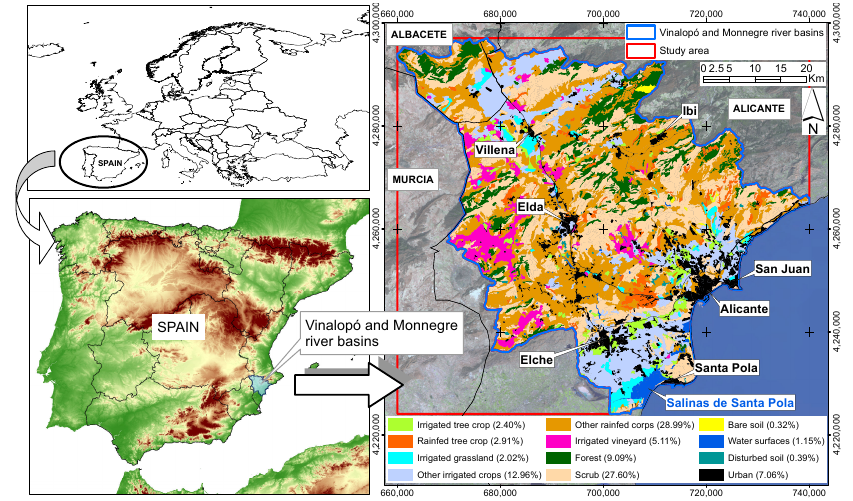
Figure 1. Study area with the 2006 Corine Land Cover map overlayed